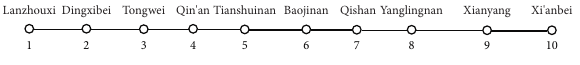
Figure 12: Schematic diagram of Lanzhou-Xi’an high-speed railway corridor. Table 2: The values of parameters h